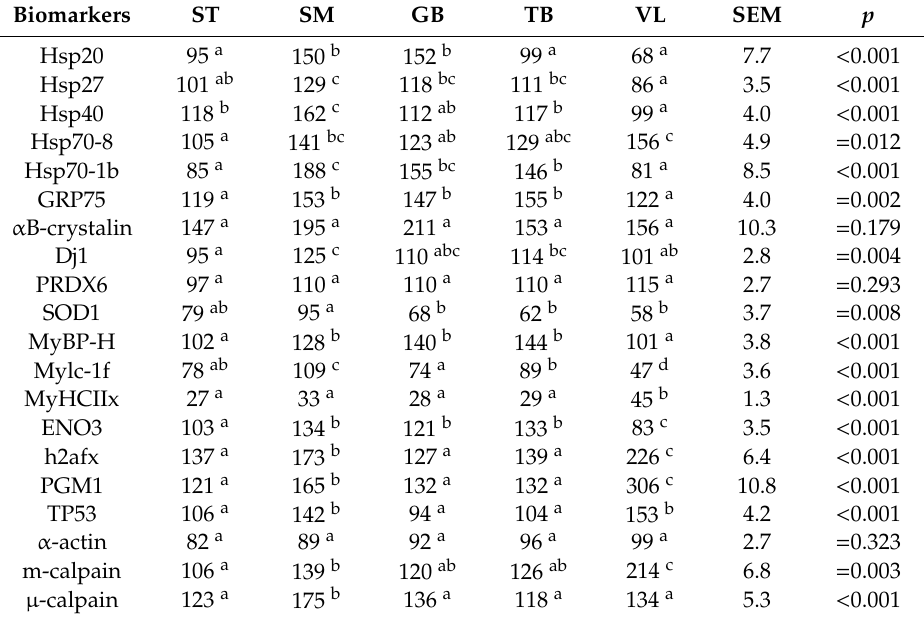
Table 3. Relative abundance of each biomarker in the five muscles.